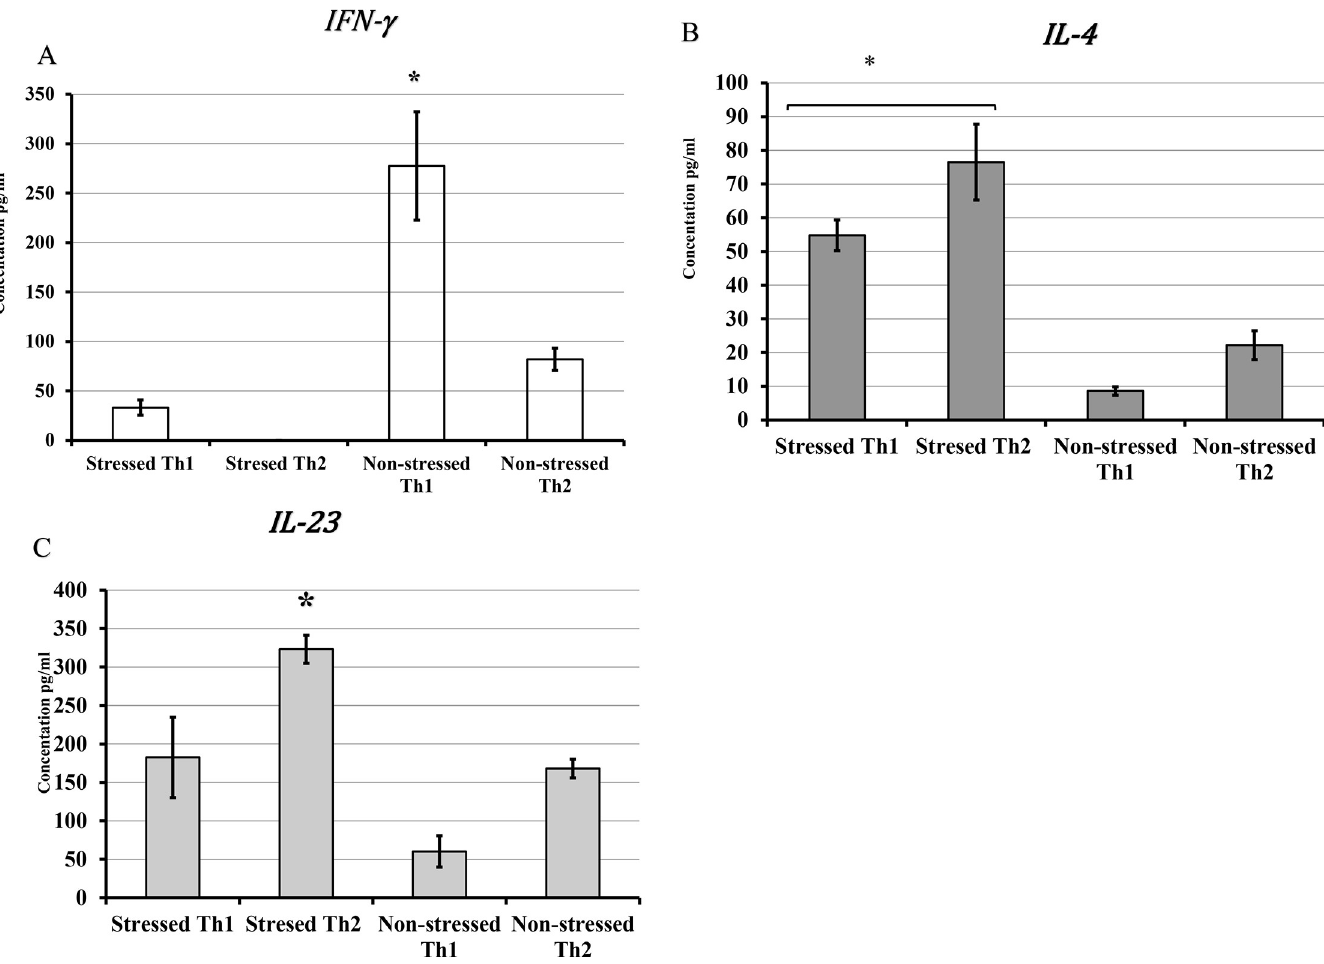
Fig 7. Polarization of na ï ve CD4+ cells in the production of signature cytokines of Th1 and Th2 cells determined by ELISA. A) IFN- γ , B) IL-4, C ) IL-23. For differentiation of Th1 cells, murine IL-12, murine IFN- γ , human IL-2, and murine anti-IL-4 were added to cell cultures in plates precoated with murine anti-CD3 for stimulation. For Th2 cells, murine IL-4, murine anti-IFN- γ and murine and anti-IL-12 were added in plates precoated with murine anti-CD3 for stimulation. The production of cytokines was determined by ELISA. Data shown is a mean +/_ SEM of two or more independent experiments performed on different